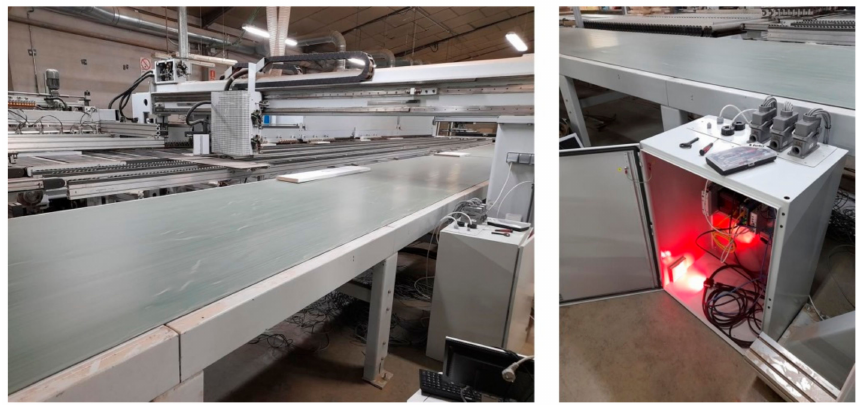
Figure 5. Edge banding machine and detail of the electrical cabinet in the production